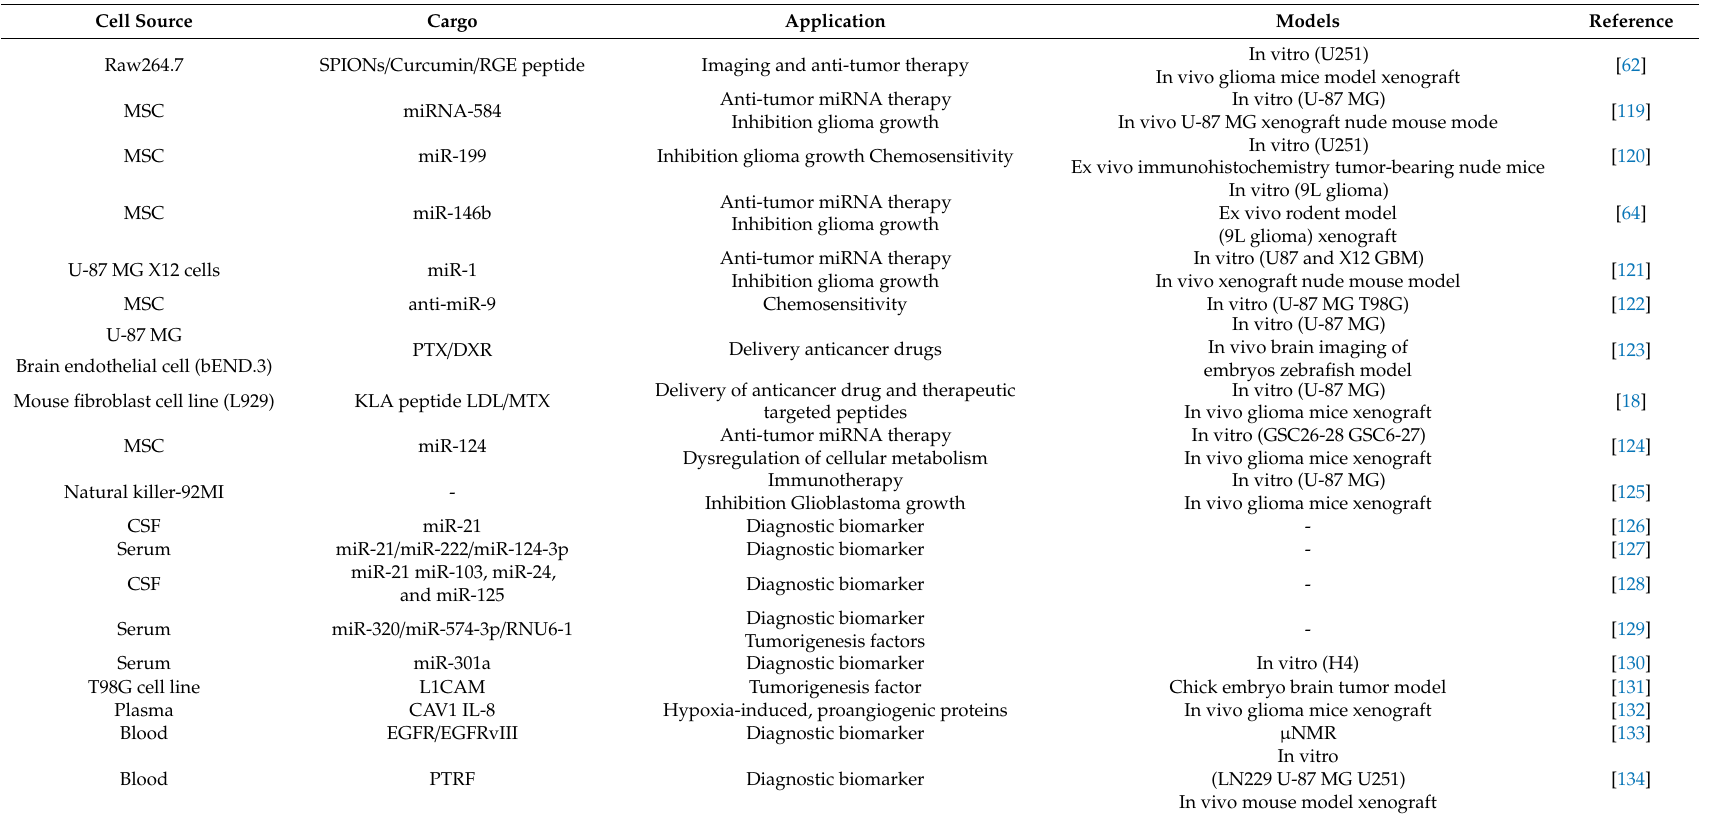
Table 2. Summary of the literature assessing exosomes as a drug delivery system and diagnostic biomarkers in in vitro and in vivo glioma